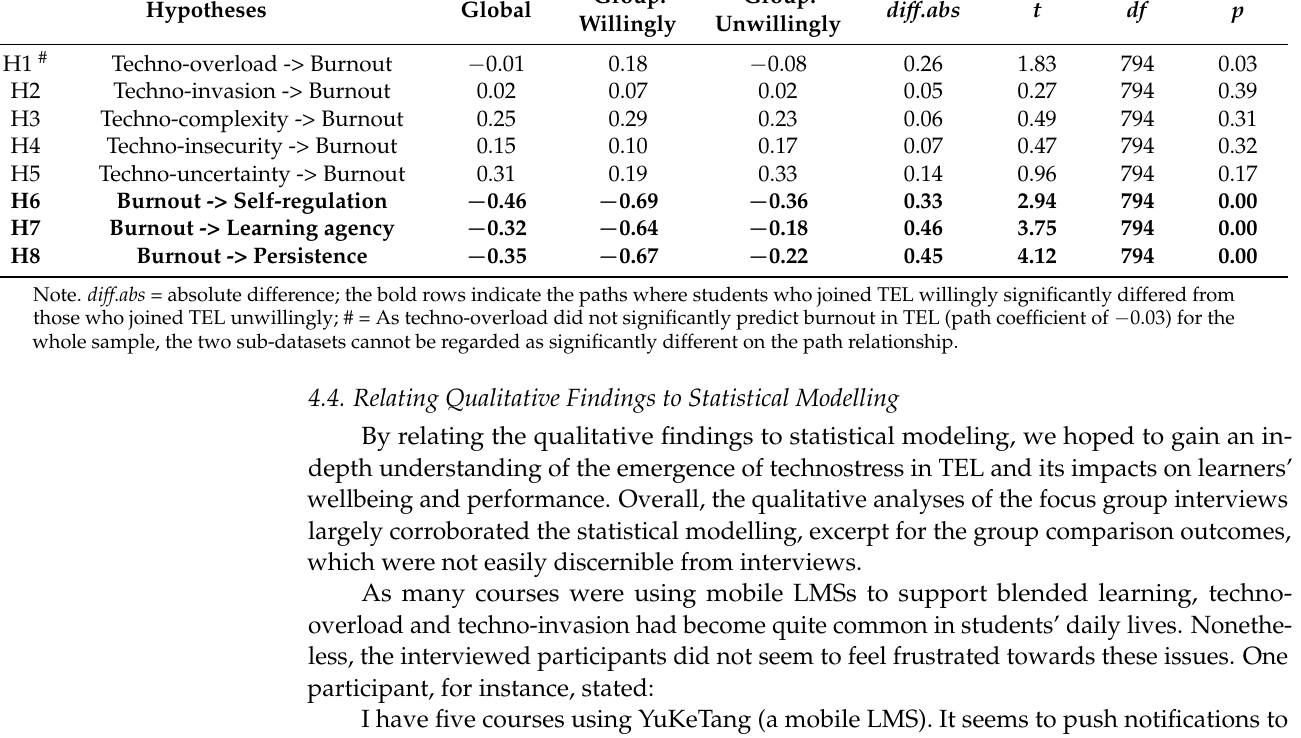
Table 6. Comparison between students who joined TEL willingly ( N = 568) and unwillingly ( N = 228).